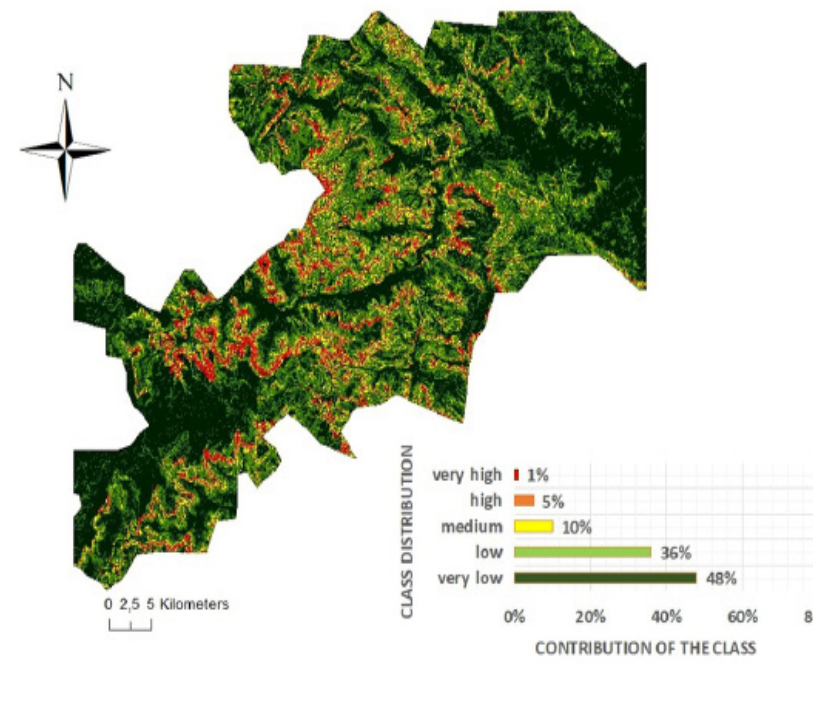
Figure 9. Komati Gorge